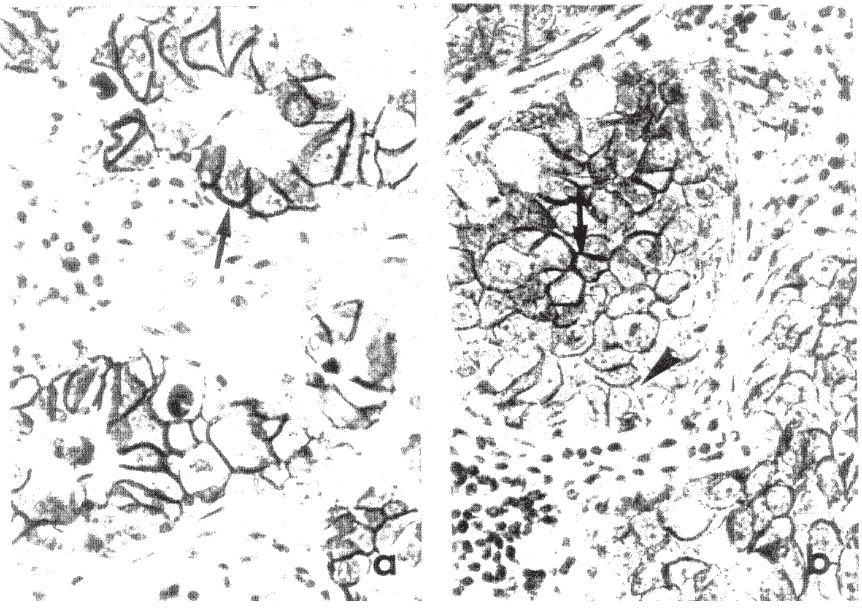
Fig. 2. Immunohistochemical staining for c-erbB-2 oncoprotein on formalin-fixed paraffin-embedded sections from primary breast carcinoma. Tumour cells with markedly (arrow) or weak (arrow head) stained membranes are seen in infiltrating duc- tal carcinomas (a), (b). Some of the tumour cells show faint cytoplasmic staining (b). Method: immunoperoxidase staining technique using monoclonal c-erbB-2 antibody. Counterstain hematoxylin. ×